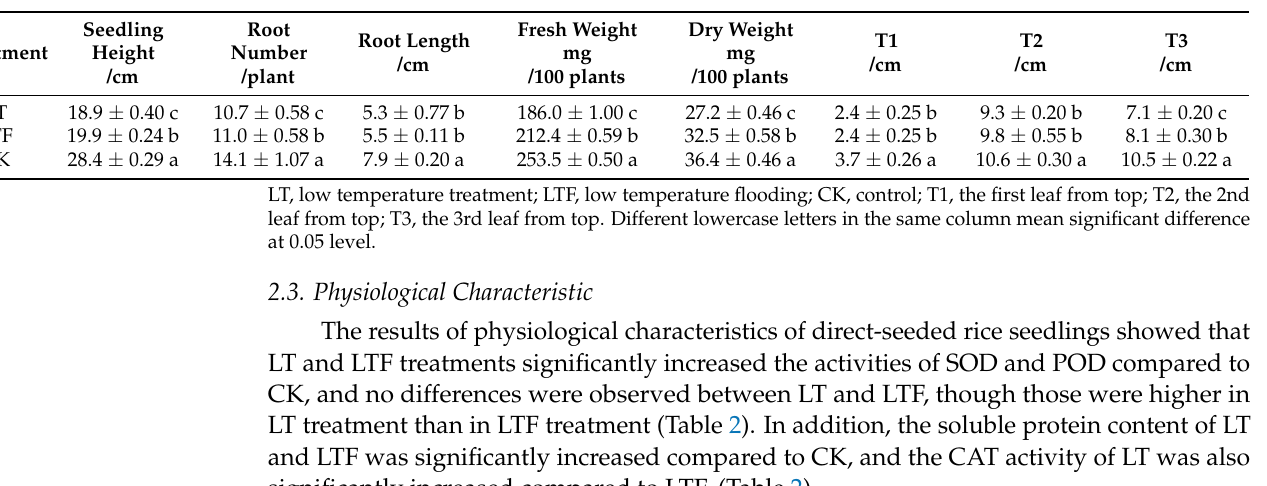
Table 1. Effects of LT and LTF stress on agronomic characters.